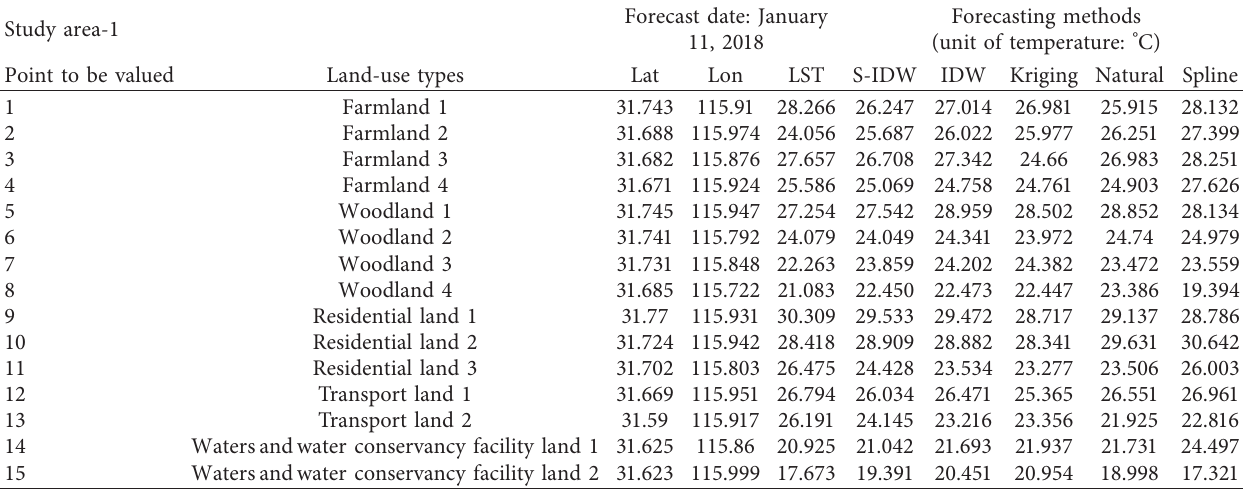
Table 6: Comparison of interpolation results of 5 kinds of interpolation methods on Apr. 17, 2018.